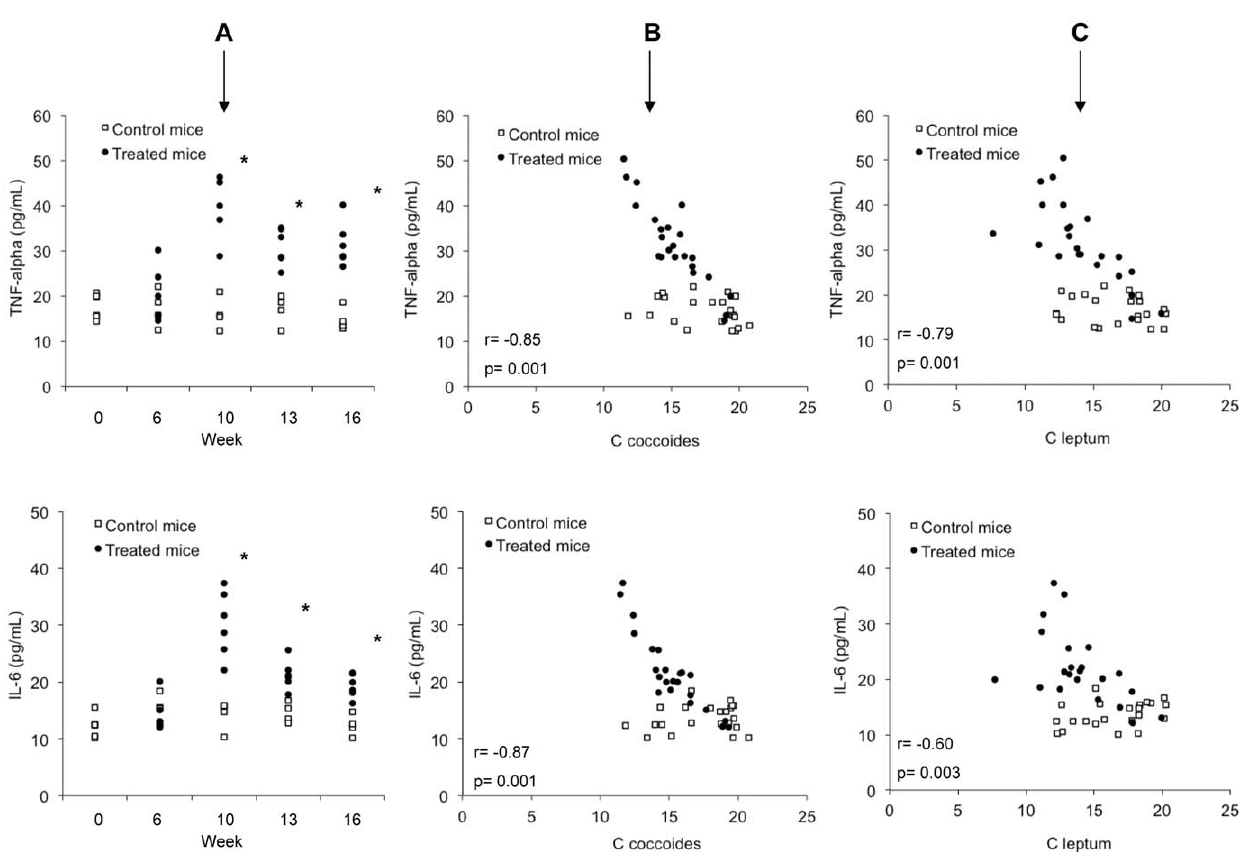
Figure 4. Pro-inflammatory cytokine profile along the study protocol. (A) TNF- a and IL-6 serum levels in control (n=4/week) and treated mice (n=6/week). Values, measured by cytometric bead arrays, obtained from each single mouse at different study weeks are represented in the Figure. * p , 0.05 compared with the weekly control group. (B) Correlation between serum TNF- a and IL-6 with C. coccoides counts from samples of intestinal cecum content in all control (n=22) and treated mice (n=24) included in the study. (C) Correlation between serum TNF- a and IL-6 with C. leptum counts from samples of intestinal cecum content in all control (n=22) and treated mice (n=24) included in the study.